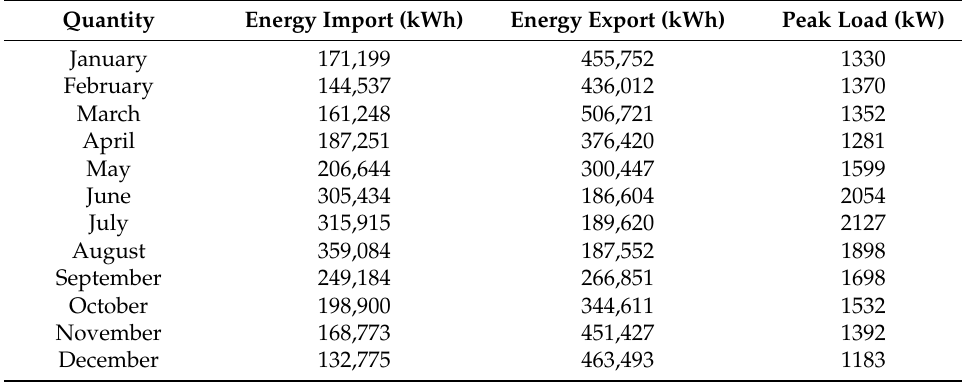
Figure 11. Annual thermal energy production by the system. Table 7. Energy import and export with local grid station and peak load demand.